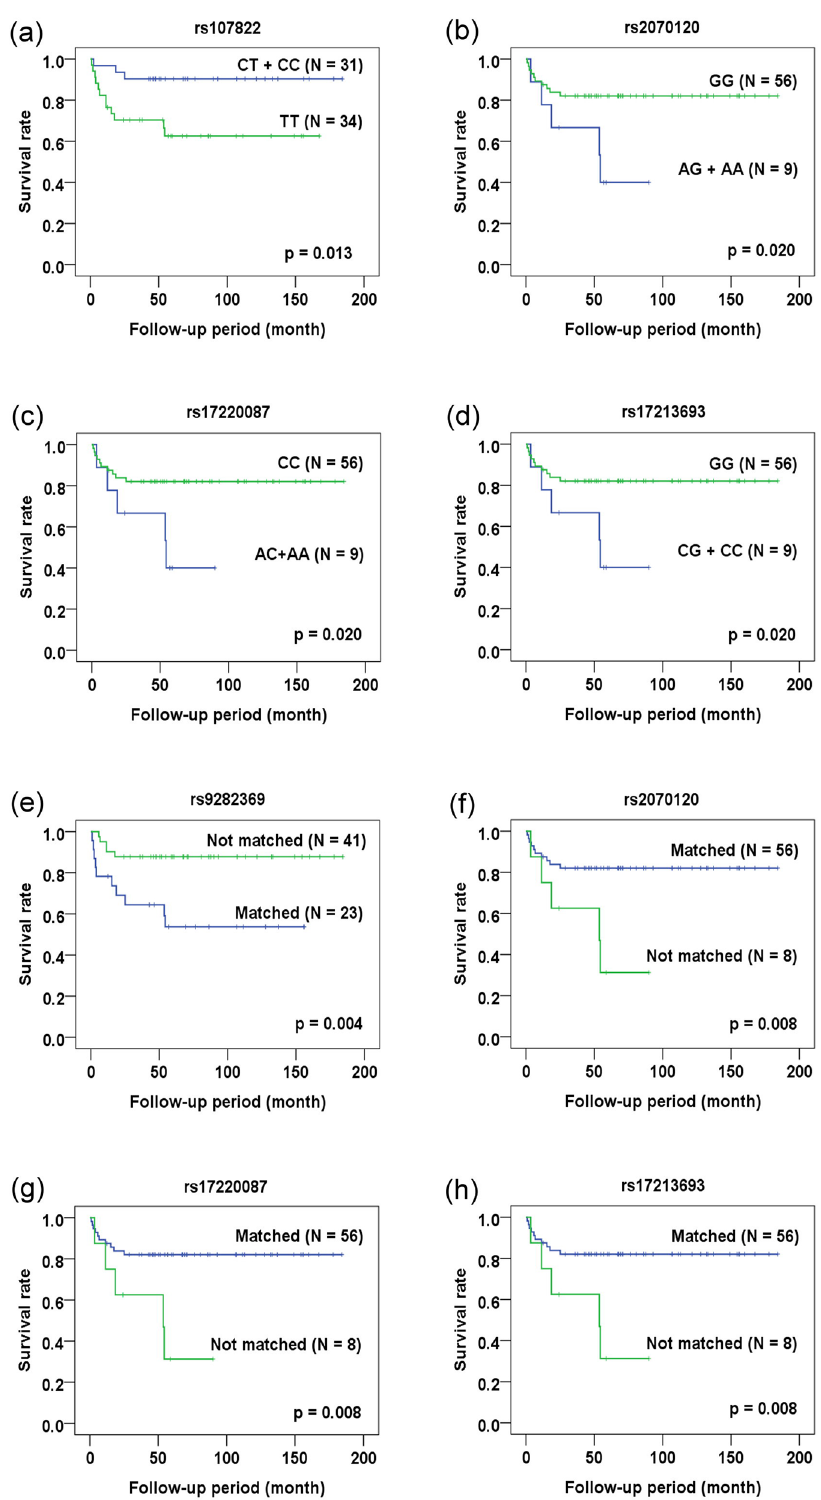
Figure 3. Kaplan–Meier analysis of overall survival. ( a – h ) The survival-related SNPs as revealed by end-point analysis were subject to Kaplan–Meier analysis. The overall survival status for recipients with the indicated genotypes (panels a – d ) or matched vs not matched status for the donor and recipient genotype was plotted against the follow-up period (month) after